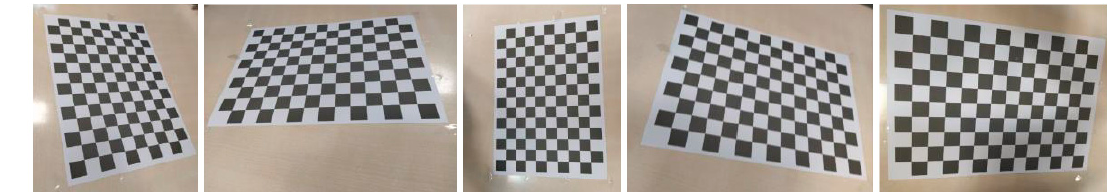
Figure 19. Sample chess-board pattern images from the RGB camera that collected in our laboratory.